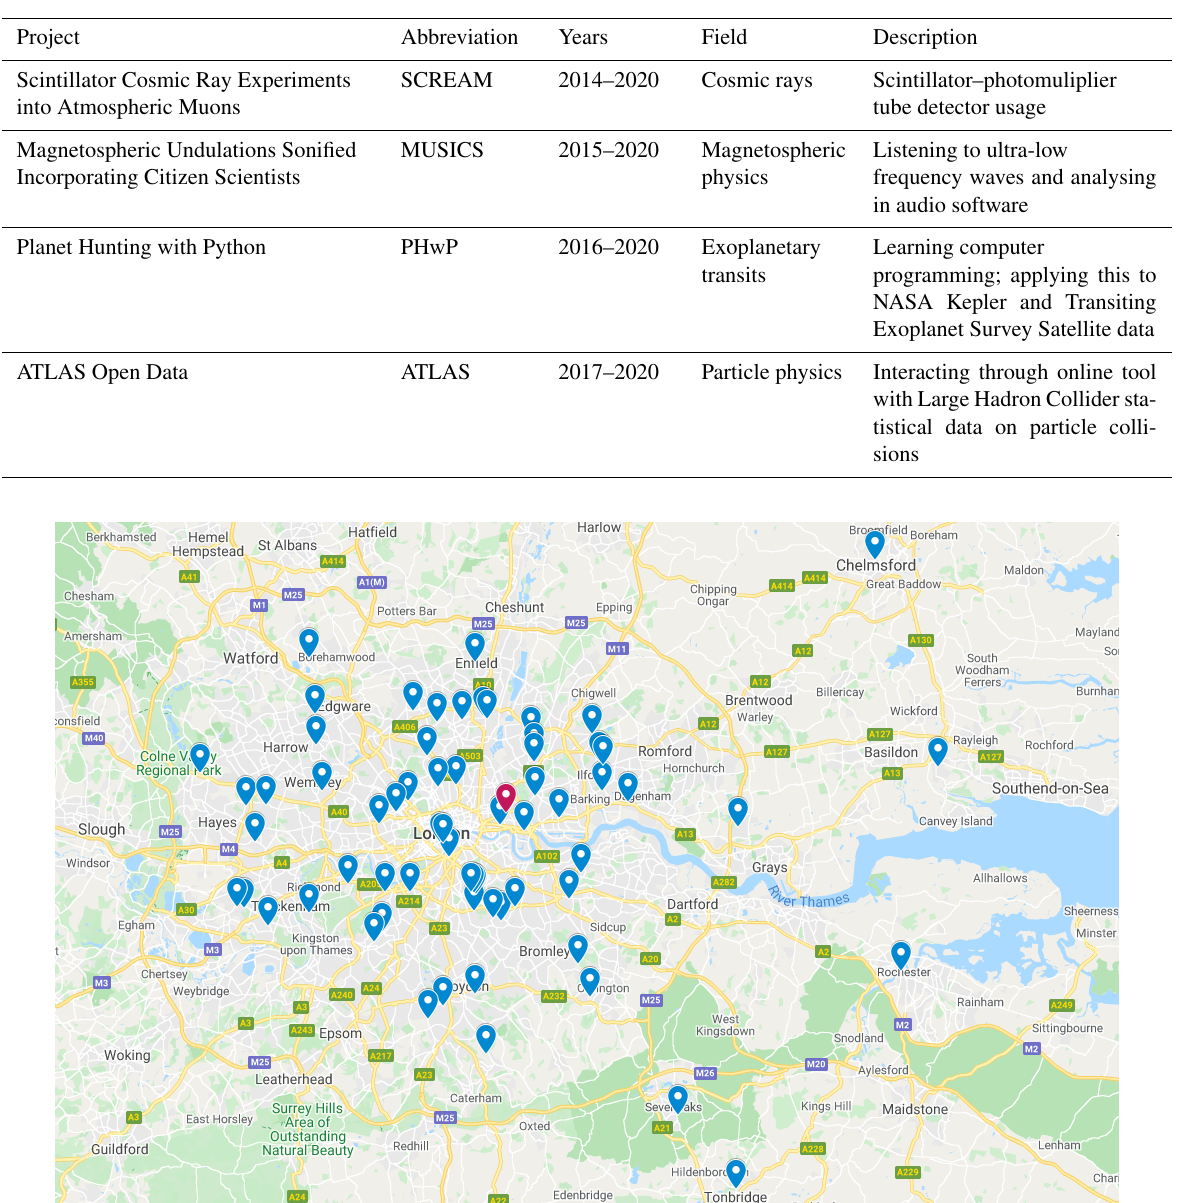
Table 1. A summary of the existing PRiSE projects at QMUL.